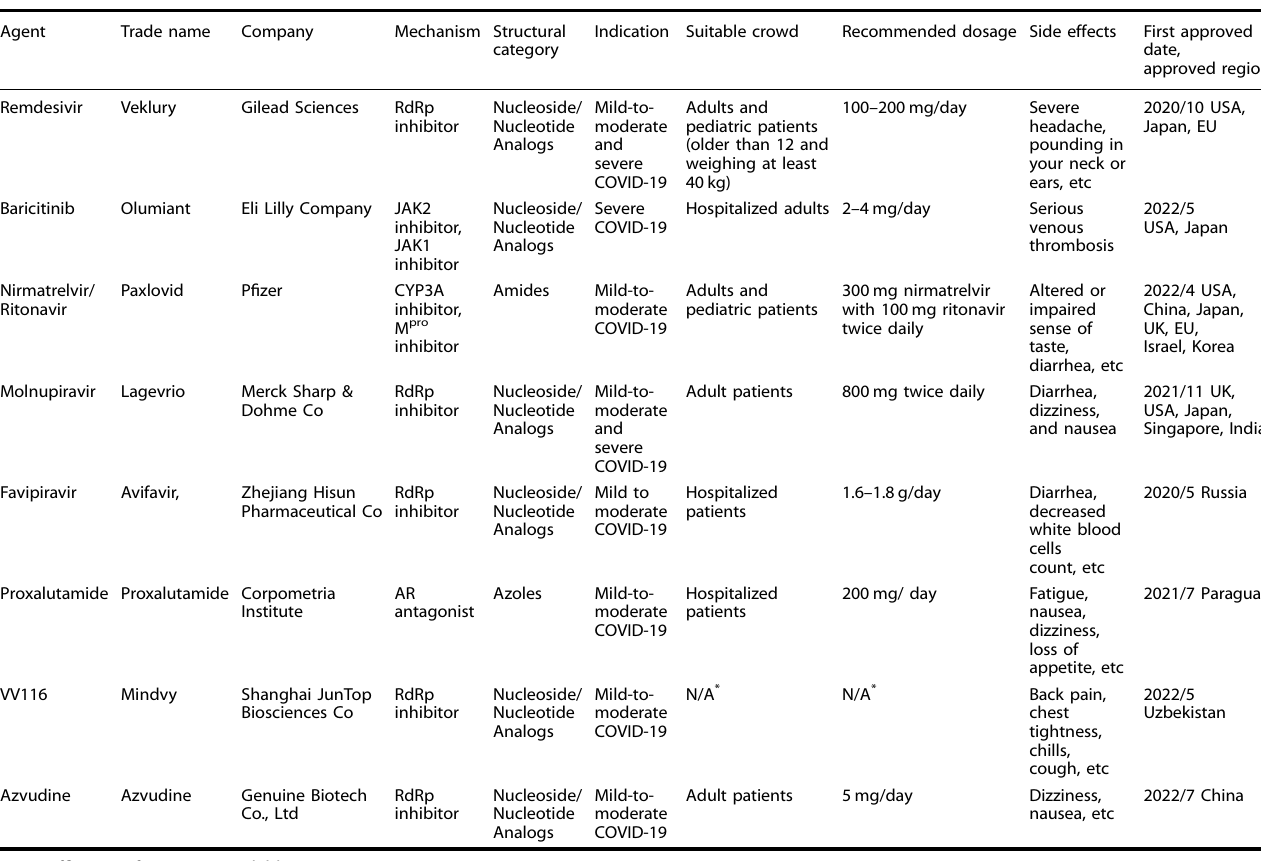
Table 1. Approved/authorized